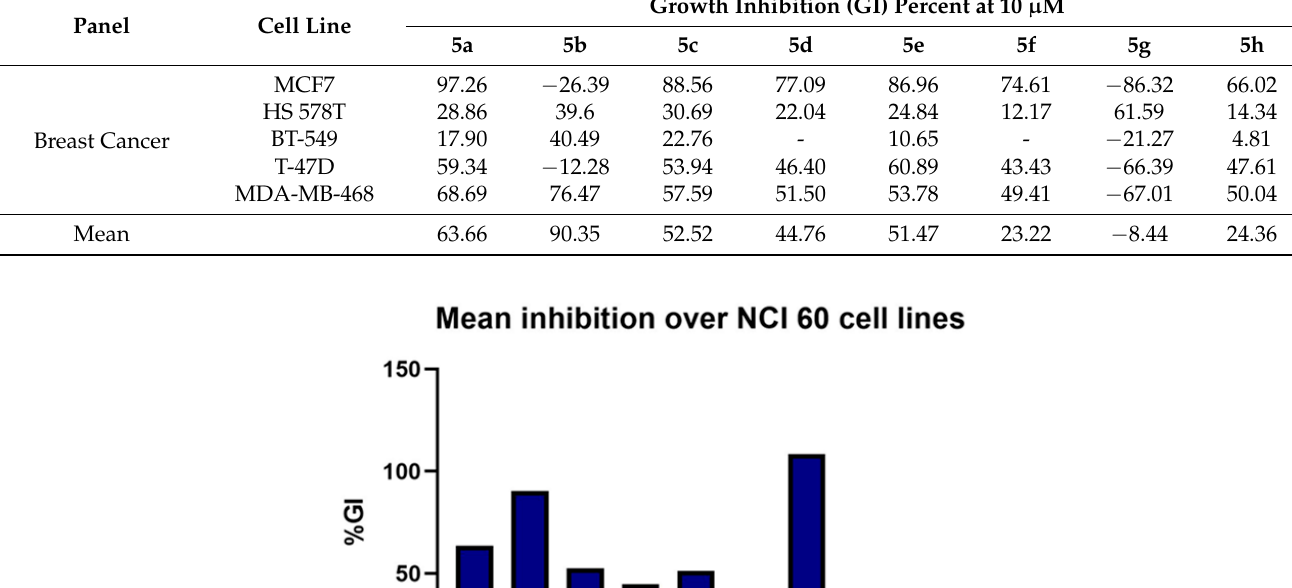
- - All IC 50 values are the mean ± standard error of three different experiments. -: not tested. 3.2.2. Analysis of Apoptosis/Necrosis Induction by 5b and 5g Annexin V-based flow cytometry analysis is used to identify the mechanism of cell death, whether achieved through programmed apoptosis or non-specific necrosis [41]. Therefore, Annexin V-FTIC/7-AAD dual staining assay was undertaken for the most ac- tive compounds 5b and 5g on HL-60 cells. Both compounds induced early apoptosis by approximately double that of DMSO after 12 h incubation. Moreover, both compounds showed a two-fold increase in the percentage of late apoptosis/necrosis after 24 h